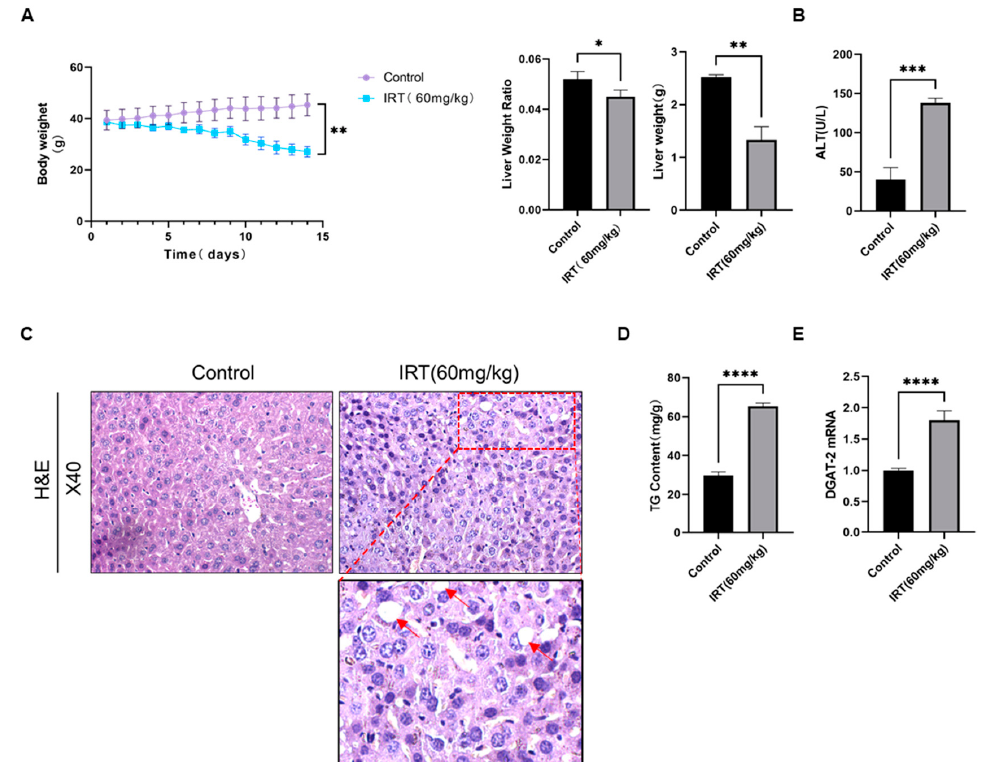
Figure 1. Irinotecan-induced liver injury in mice. Mice were intraperitoneally injected with irinotecan hydrochloride (60 mg/kg) or 5% glucose solution thrice a week on alternate days for 14 days. ( A ) Changes in body weight, liver weight, and liver-to-body weight ratio of mice after irinotecan treatment. ( B ) Serum levels of alanine aminotransferase (ALT) in mice. ( C ) Representative images of H&E staining from liver tissues of irinotecan-treated mice and control mice. The appearance of vacuoles is indicated by arrows. ( D ) Analysis of triglyceride (TG) content in liver tissues of control and irinotecan ‐ treated mice. ( E ) mRNA level of diglyceride acyltransferase 2 (DGAT2). Data are reported as mean ± SD, and each graph is representative of at least three independent experiments. Statistical significance was tested with an unpaired t ‐ test. * p < 0.05; ** p < 0.01; *** p < 0.001; **** p < 0.0001.